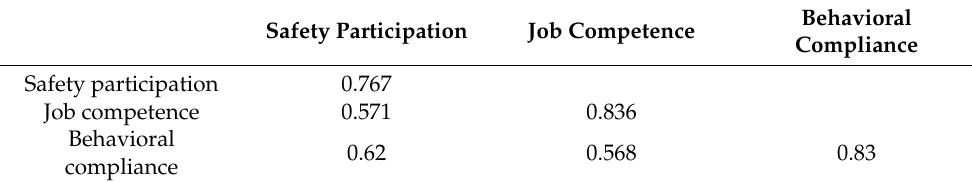
Table 5. Fornell–Larcker criterion